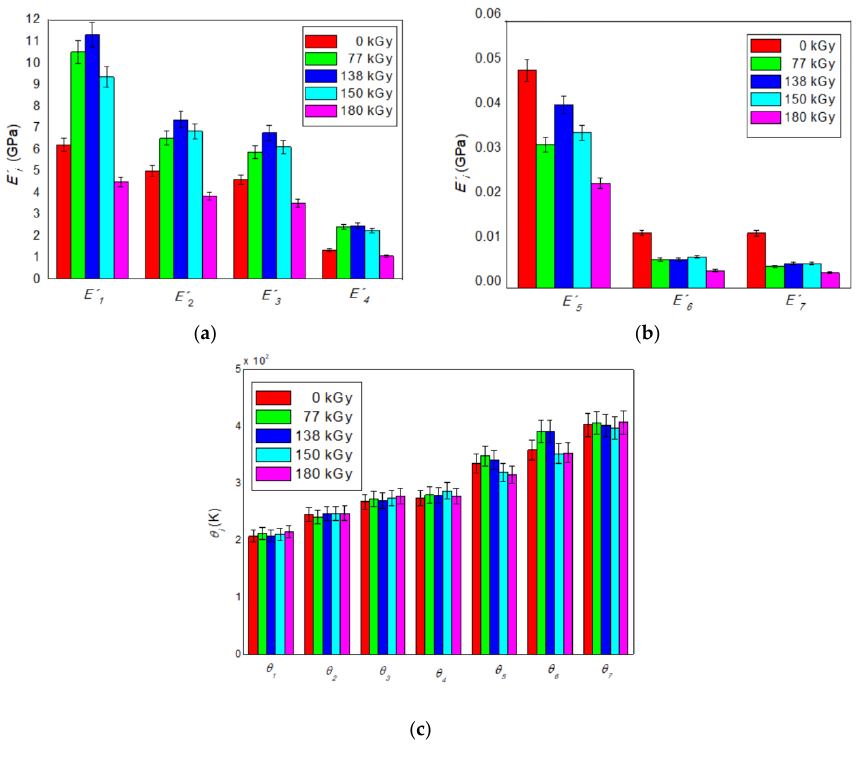
Figure 5. The influence of the radiation dose size on values of instantaneous storage moduli: ( a ) E′ 1 – E′ 4; ( b ) E′ 5 –E′ 7; ( c ) the influence of the radiation dose size on values of transition temperatures θ1 – θ7 .